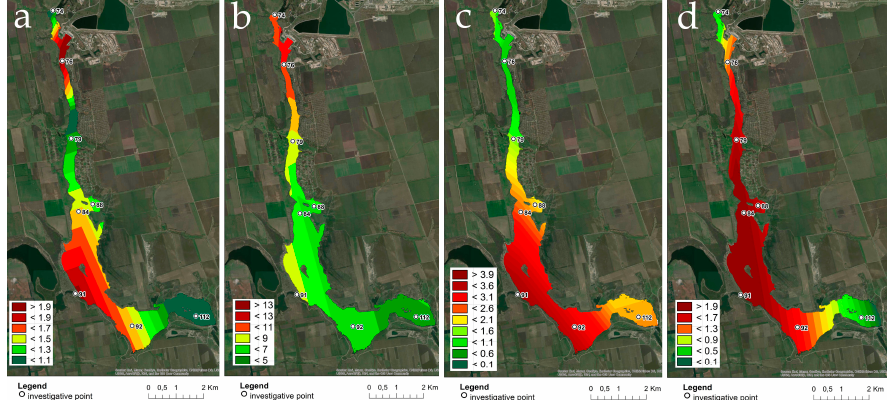
Figure 12. Combined statistical and landscape maps for species number in phytoplankton of the Tashlyk reservoir. Bacillariophyta ( a ); Chlorophyta ( b ); Cyanobacteria ( c ); Cryptophyta ( d ). Colors are given for the value amplitude of each mapped variable from green (lower boxes in the legend key) to red (upper boxes in the legend key).